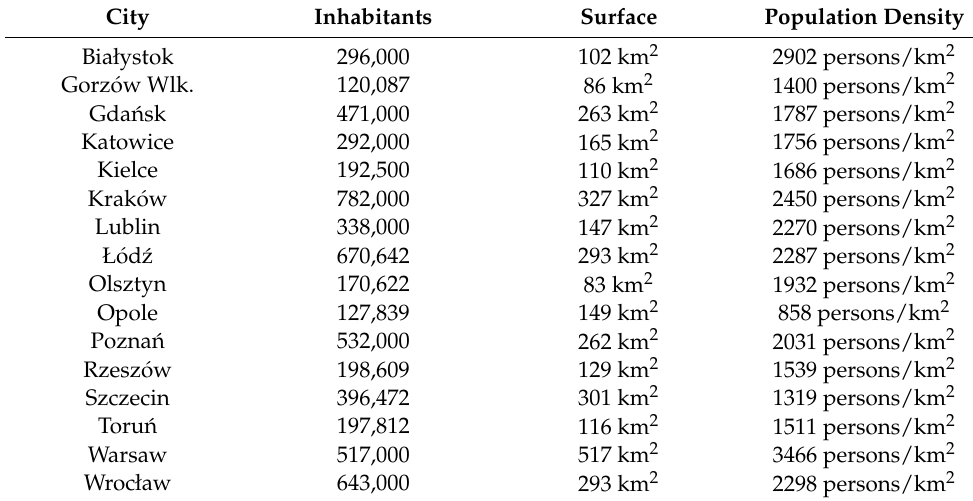
Table 1. Characteristics of the surveyed